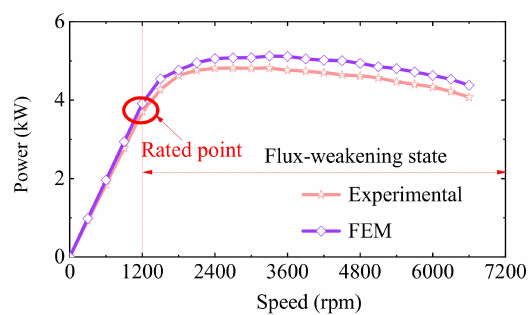
Figure 17. The torque-speed curves of the RSPMSM.